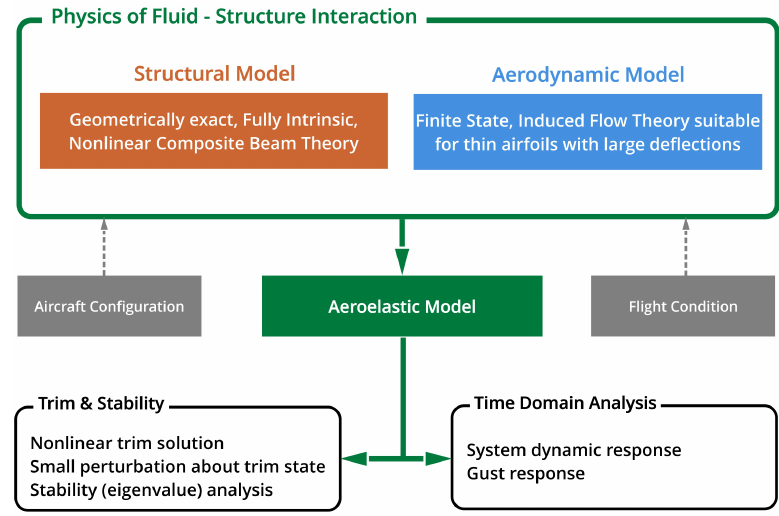
Figure 6. Workflow of